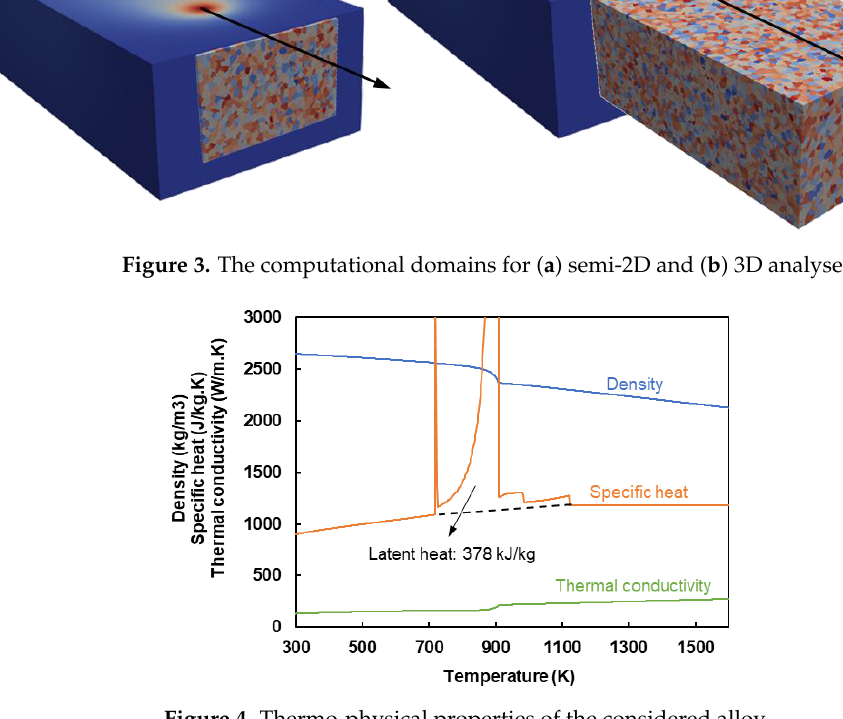
Figure 4. Thermo-physical properties of the considered alloy.